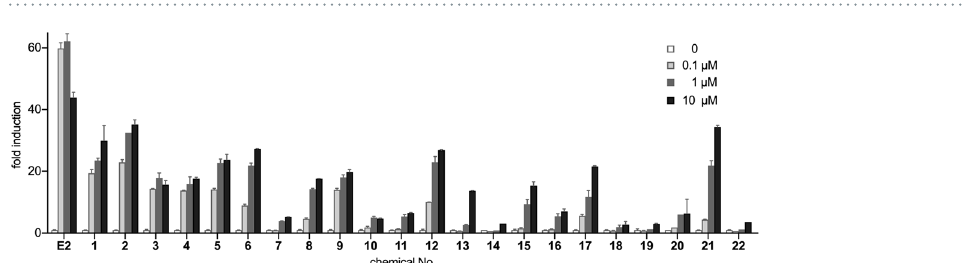
Figure 2. Agonist activities of E2 and BPA-related compounds according to luciferase-reporter assay. White bars indicate the transcriptional activity in the absence of the compounds. Transcriptional activities were evaluated by calculating fold induction from the luminescence versus that observed in the absence of each compound. The dose-dependent transcriptional activities associated with each compound are indicated by bars in light grey (0.1 μ M), grey (1 μ M), and black (10 μ M), respectively. Compound numbers are indicated in Table 1 and Fig.